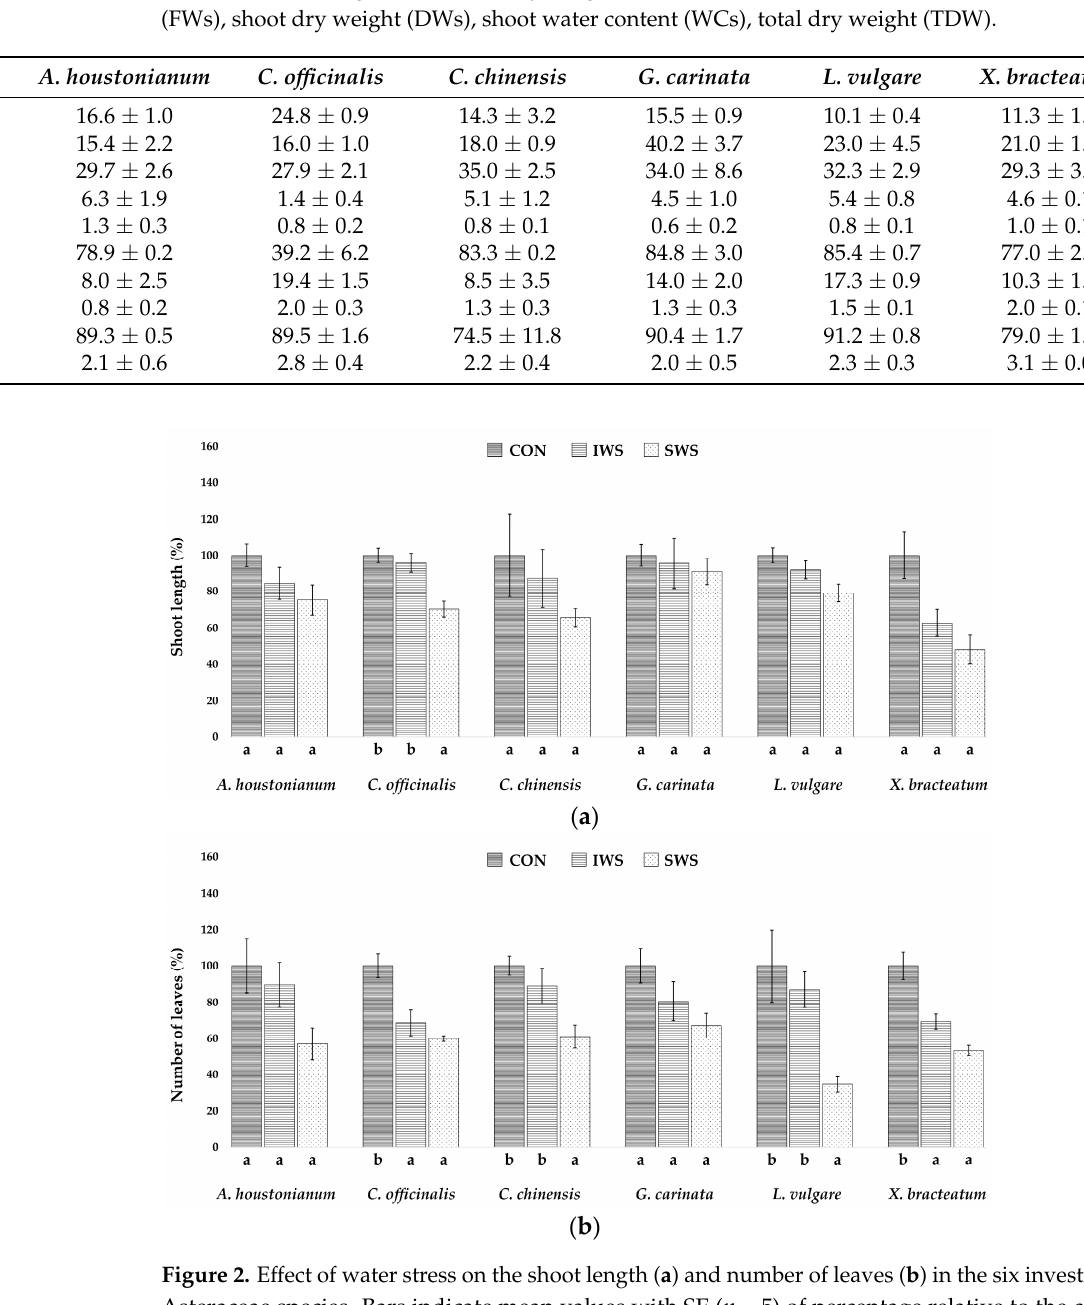
Table 1. Growth parameters of non-stressed plants from the control treatment in the selected spe- cies. Mean values followed by SE, n = 5. Abbreviations: shoot length (SL), leaf number (Ln), root length (RL), root fresh weight (FWr), root dry weight (DWr), root water content (WCr), shoot fresh weight (FWs), shoot dry weight (DWs), shoot water content (WCs), total dry weight (TDW).